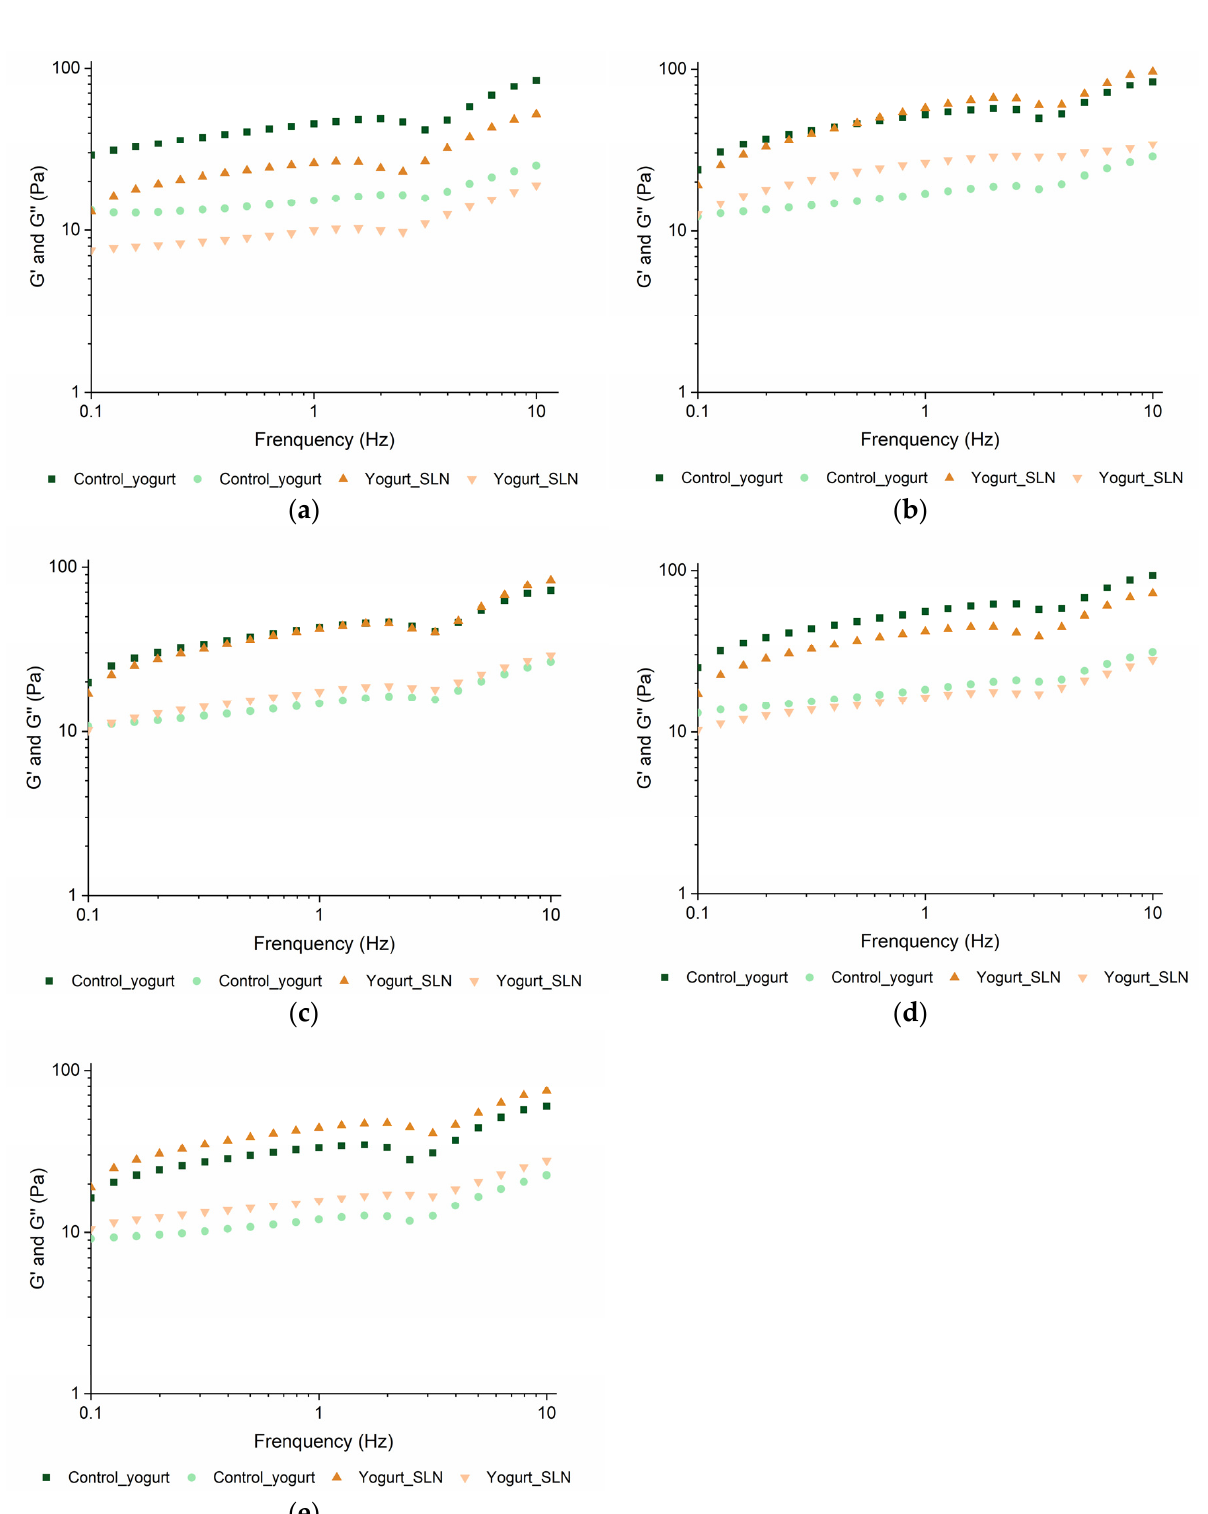
and represent G (cid:48) , and •